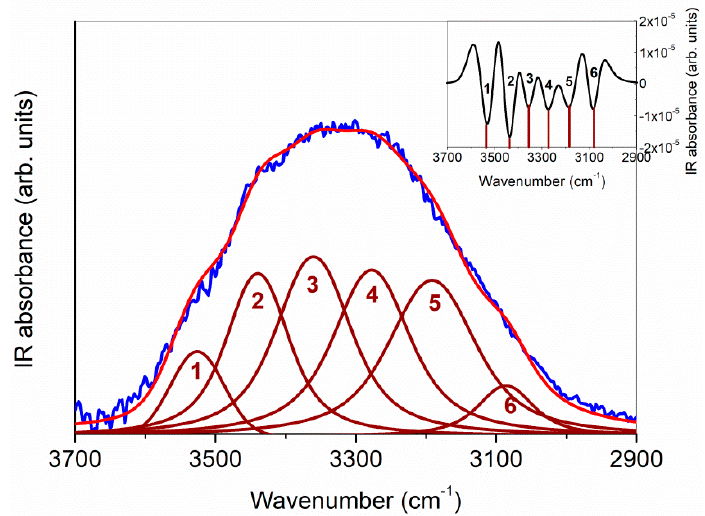
Figure 4. A typical example of best fit results for FTIR-ATR spectrum, in the 3700 − 2900 cm − 1 range, of the IDE/HP- β -CD 1:2 inclusion complex (blue line), at T = 290 K as an example. In the inset, the corresponding diagram of the second-derivative computation of the experimental spectrum is shown, clearly evidencing the existence of six minima. See text for details.